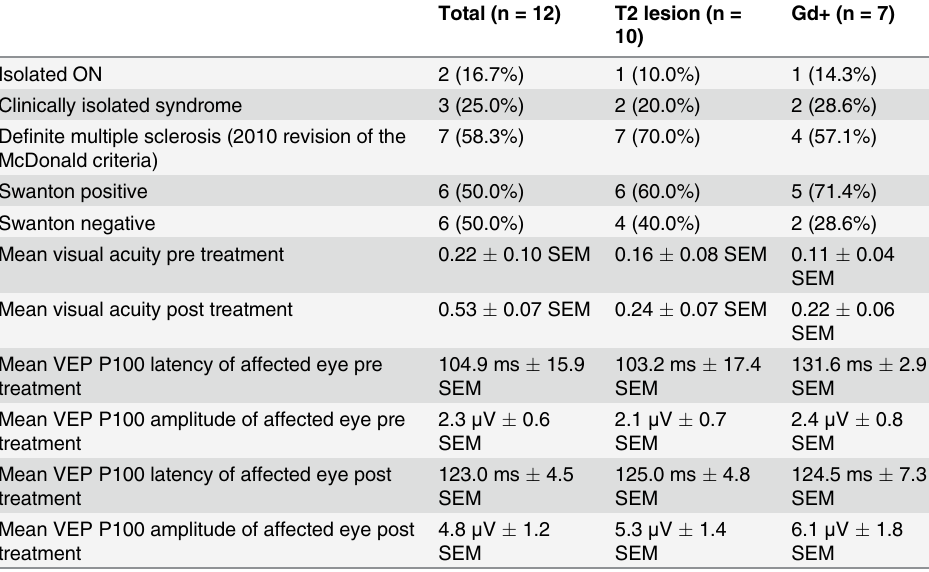
Table 4. Characteristics of patients receiving plasma exchange